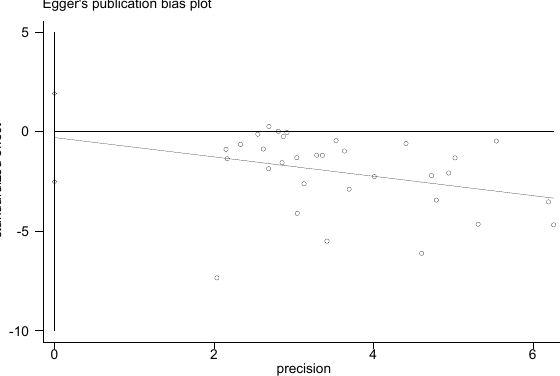
Figure 12. Egger’s test for evaluating the publication bias of cIMT.